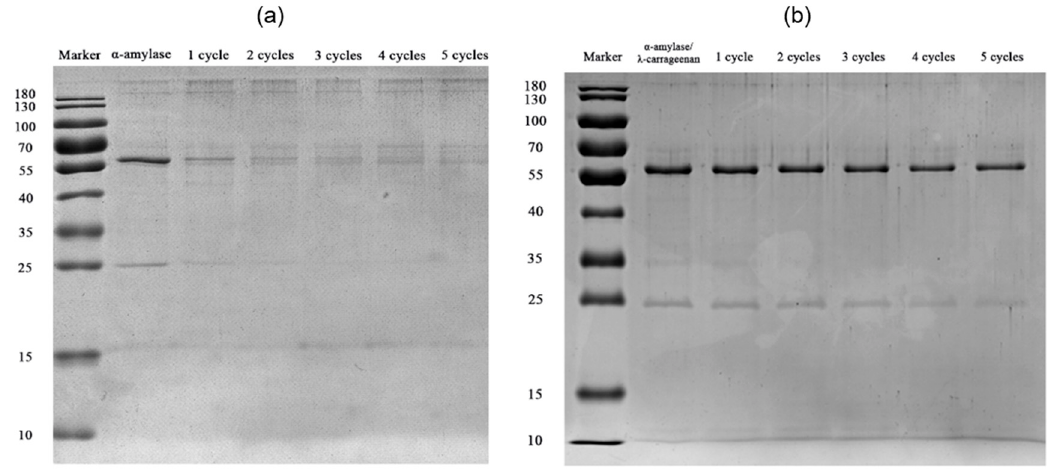
Figure 8. SDS-PAGE of α -amylase ( a ) and α -amylase/ λ -carrageenan complexes with a ratio of 10:1 ( b ) after PEF treatment, n represents the number of cycles.